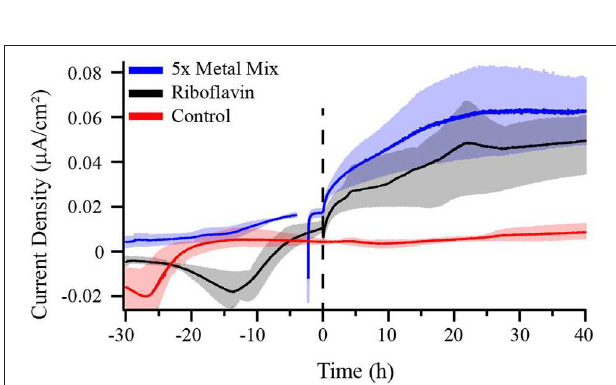
FIGURE 6 | Chronoamperometry of M. atlanticus biofilms grown on carbon cloth electrodes poised at 310mV vs. SHE with either no additions to the growth medium (red), 1mL of sterile-filtered Wolfe’s Mineral Solution added after ca. 48h post inoculation (blue), or 3.5 µ M riboflavin (final concentration) added after ca. 30h post inoculation (black). Solid lines represent an average of triplicate (control and riboflavin addition) or duplicate (mineral mix addition) bioelectrochemical systems (BES) and the shaded areas represent the maximum and minimum values